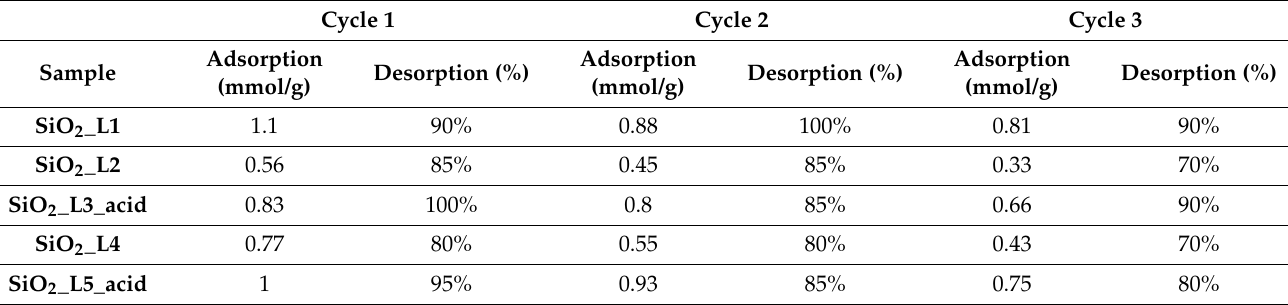
Table 6. Reusability of grafted SiO 2 NPs after 3 cycles of Sm adsorption and desorption